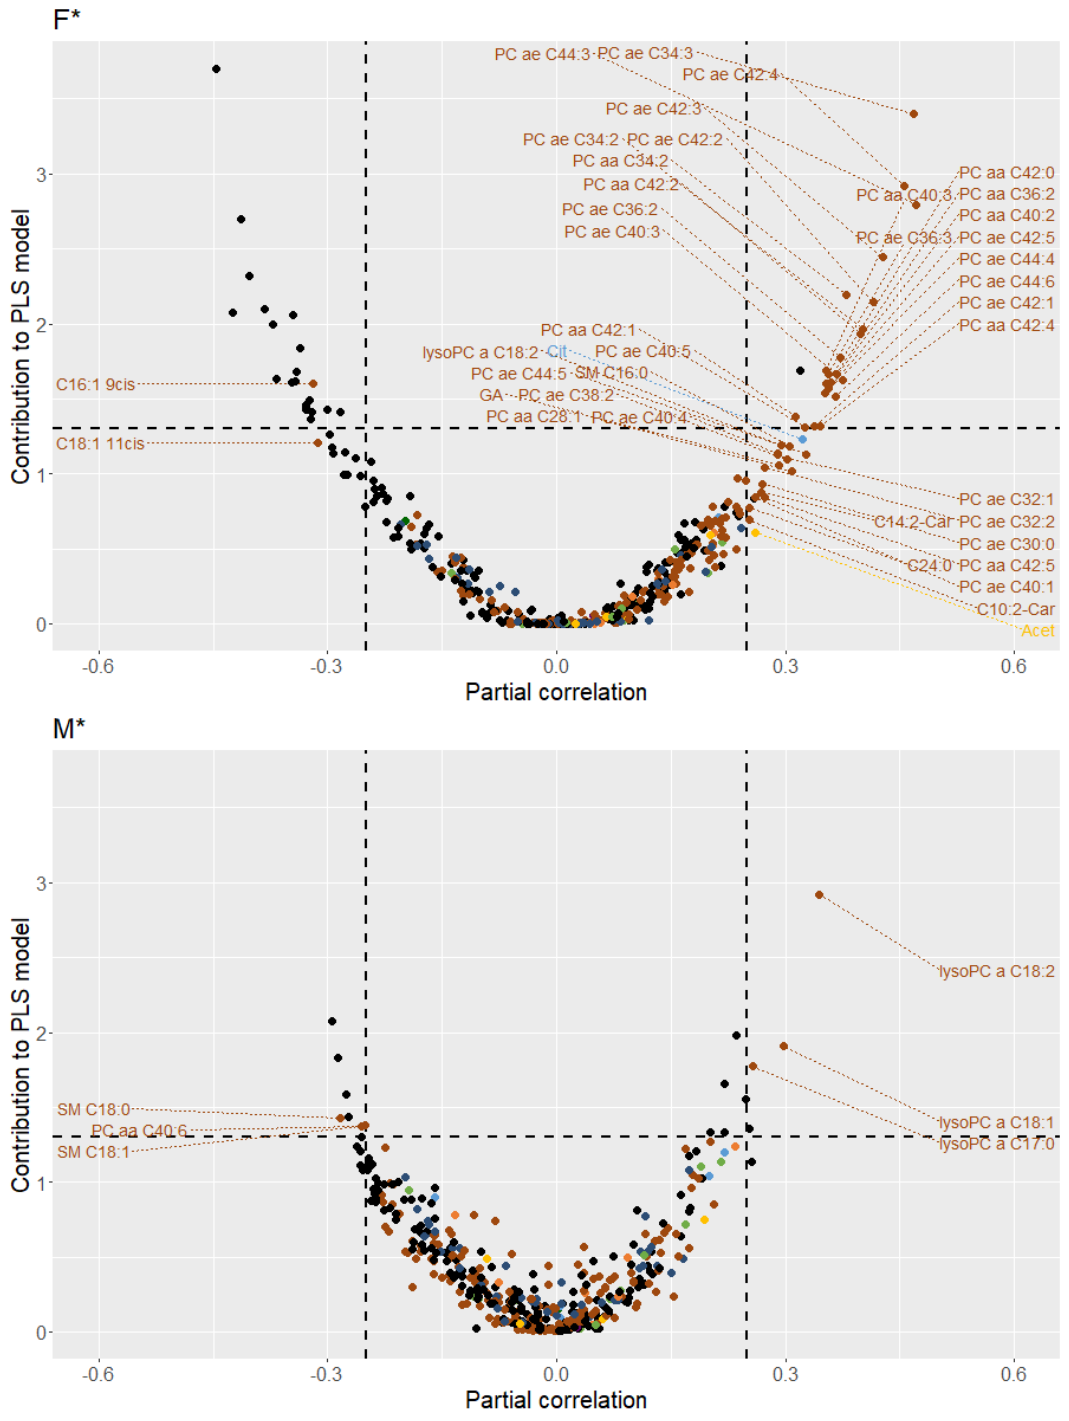
Figure 3. Volcano plots illustrating sex-specific plasma metabolite patterns associated with the VO 2peak . F: females; M: males. * confounder (age/menopausal status)-adjusted. The y-axis represents the significance of the contribution of each metabolite variable to the multivariate association with the VO 2peak , expressed as the negative logarithm of the relative frequencies of permutation-obtained rank products below measured rank products. The x-axis illustrates the direction and strength of partial correlations between the VO 2peak and metabolite variables, expressed as Pearson correlation coefficients (r) of Van der Waerden (VdW)-transformed variables. The classification of plasma analytes to major metabolic pathways is color-coded as follows: amino acid metabolism (dark blue); carbohydrate metabolism (yellow); cofactors and vitamins metabolism (dark green); energy metabolism (light blue); lipid metabolism (brown); mammalian-microbial cometabolism (orange); nucleotide metabolism (purple); xenobiotics and related metabolism (light green); unknown (black).